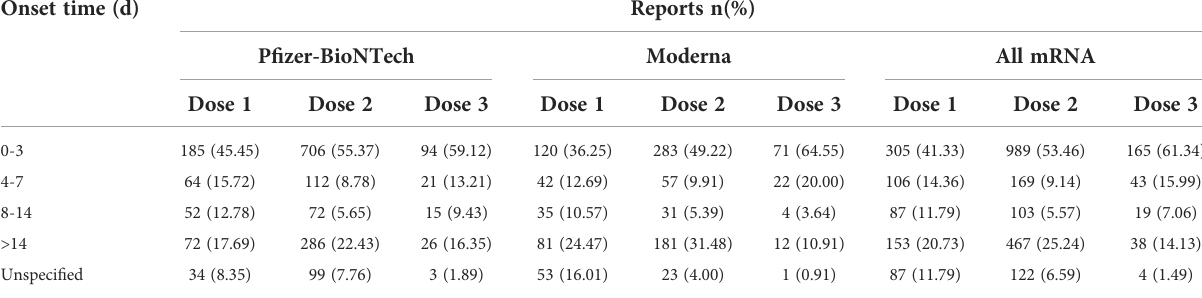
TABLE 6 Time to event onset of myocarditis/pericarditis following different doses of mRNA coronavirus 2019 (COVID-19) vaccination. Onset time